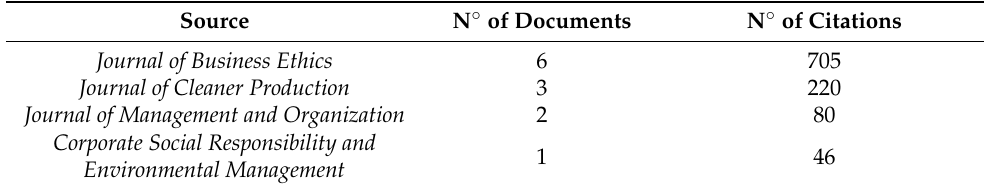
Table 3. Top four citations per source. Source N ◦ of